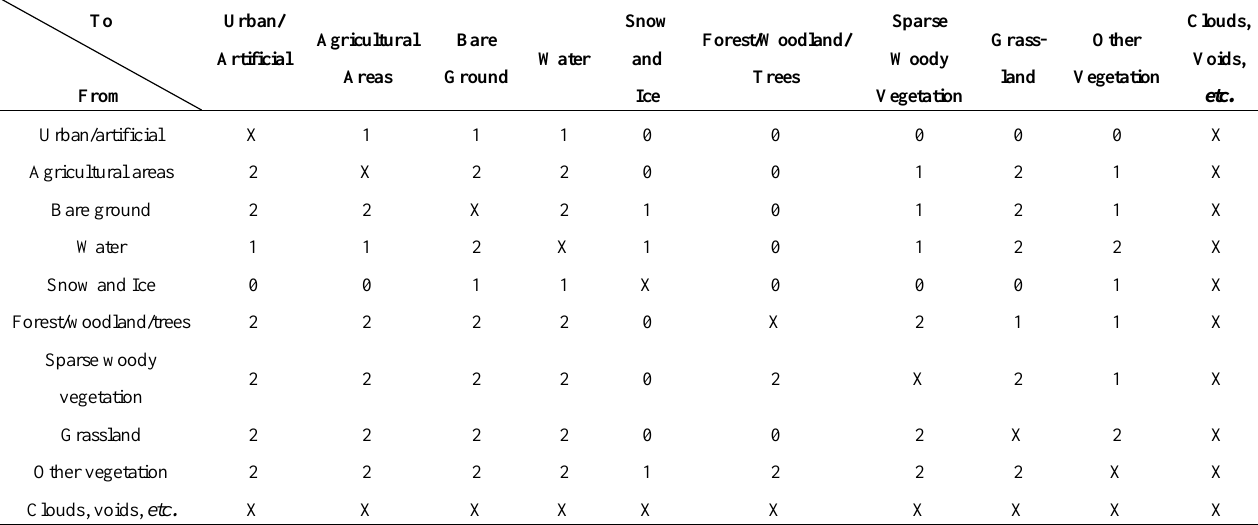
Table 1. Combinations of land cover changes that may take place during one